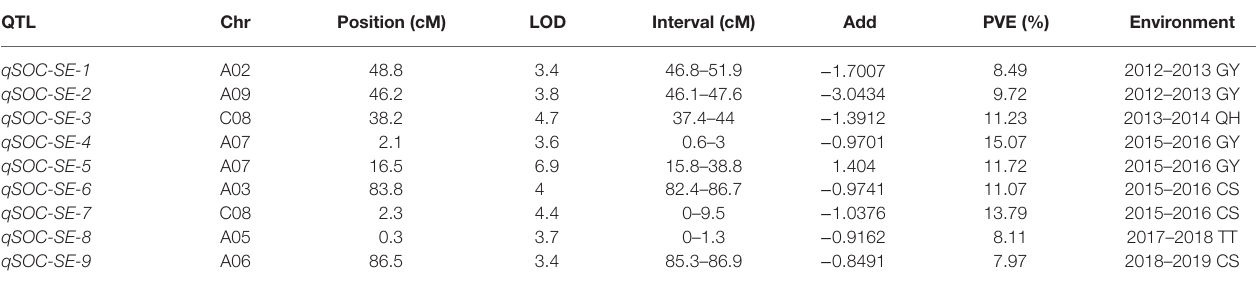
TABLE 5 | Major QTLs for SOC identified in single